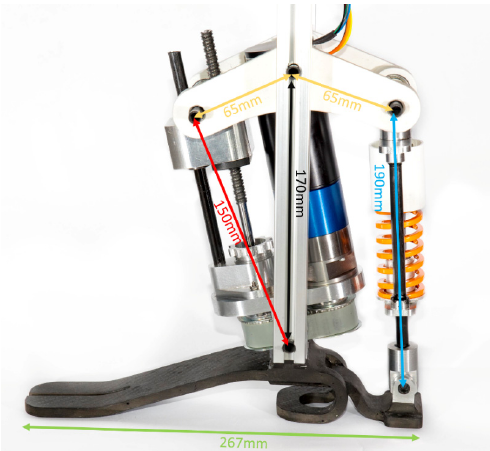
Figure 5. An image of the prototype of the ankle-foot prosthesis with the main dimensions (the actuator and shock-absorber dimensions refer to the condition at γ = 90°).